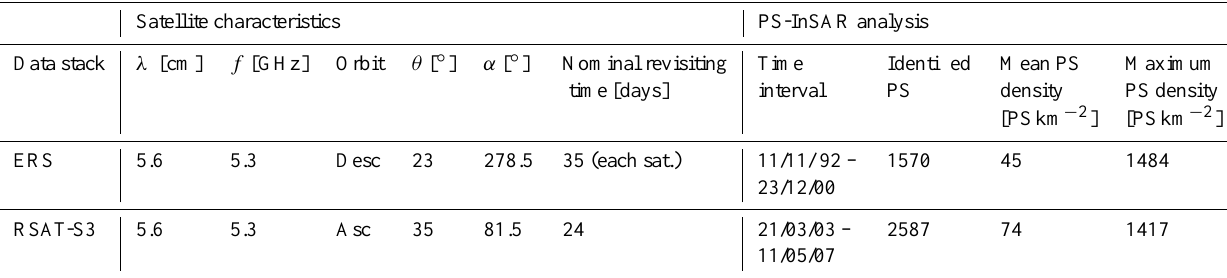
Table 1. Main characteristics of ERS and RSAT-S3 (RADARSAT-1 in Standard Beam Mode 3) PS-InSAR analyses for the town of Naro. Mean PS density is relative to the whole analyzed area (about 35km 2 ) , while maximum density is calculated for the inner urban area. λ , signal wavelength; f , signal frequency; θ , look angle – measured between the LOS and the vertical direction; α , azimuth – measured between the N direction and the LOS; Desc, descending; Asc,